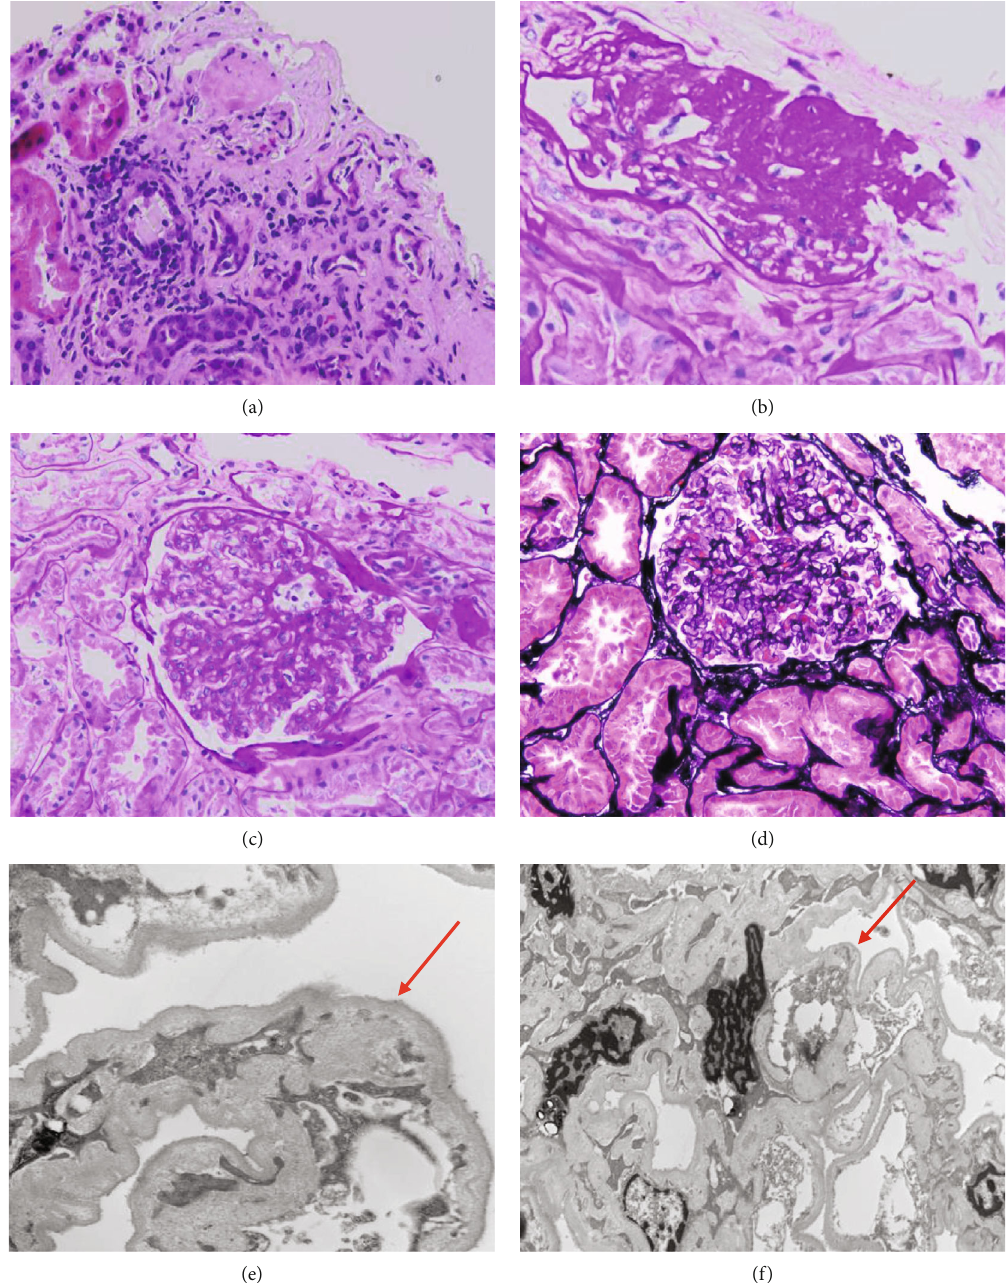
Figure 4: FSGS: (a) renal cortex with glomerulosclerosis and focal interstitial fi brosis, H&E stain (100x magni fi cation). (b) Global glomerulosclerosis, PAS stain (200x magni fi cation). Normal glomeruli, by de fi nition, must coexist with the pathological process for the diagnosis of FSGS, PAS stain (c) and silver stain (d) (200x magni fi cation). Electron microscopy: (e) foot process e ff acement, epithelial cell detachment from glomerular basement membrane, and capillary wrinkling (15,000x magni fi cation). (f) Retraction of tufts and wrinkling of capillary walls (12,000x magni fi